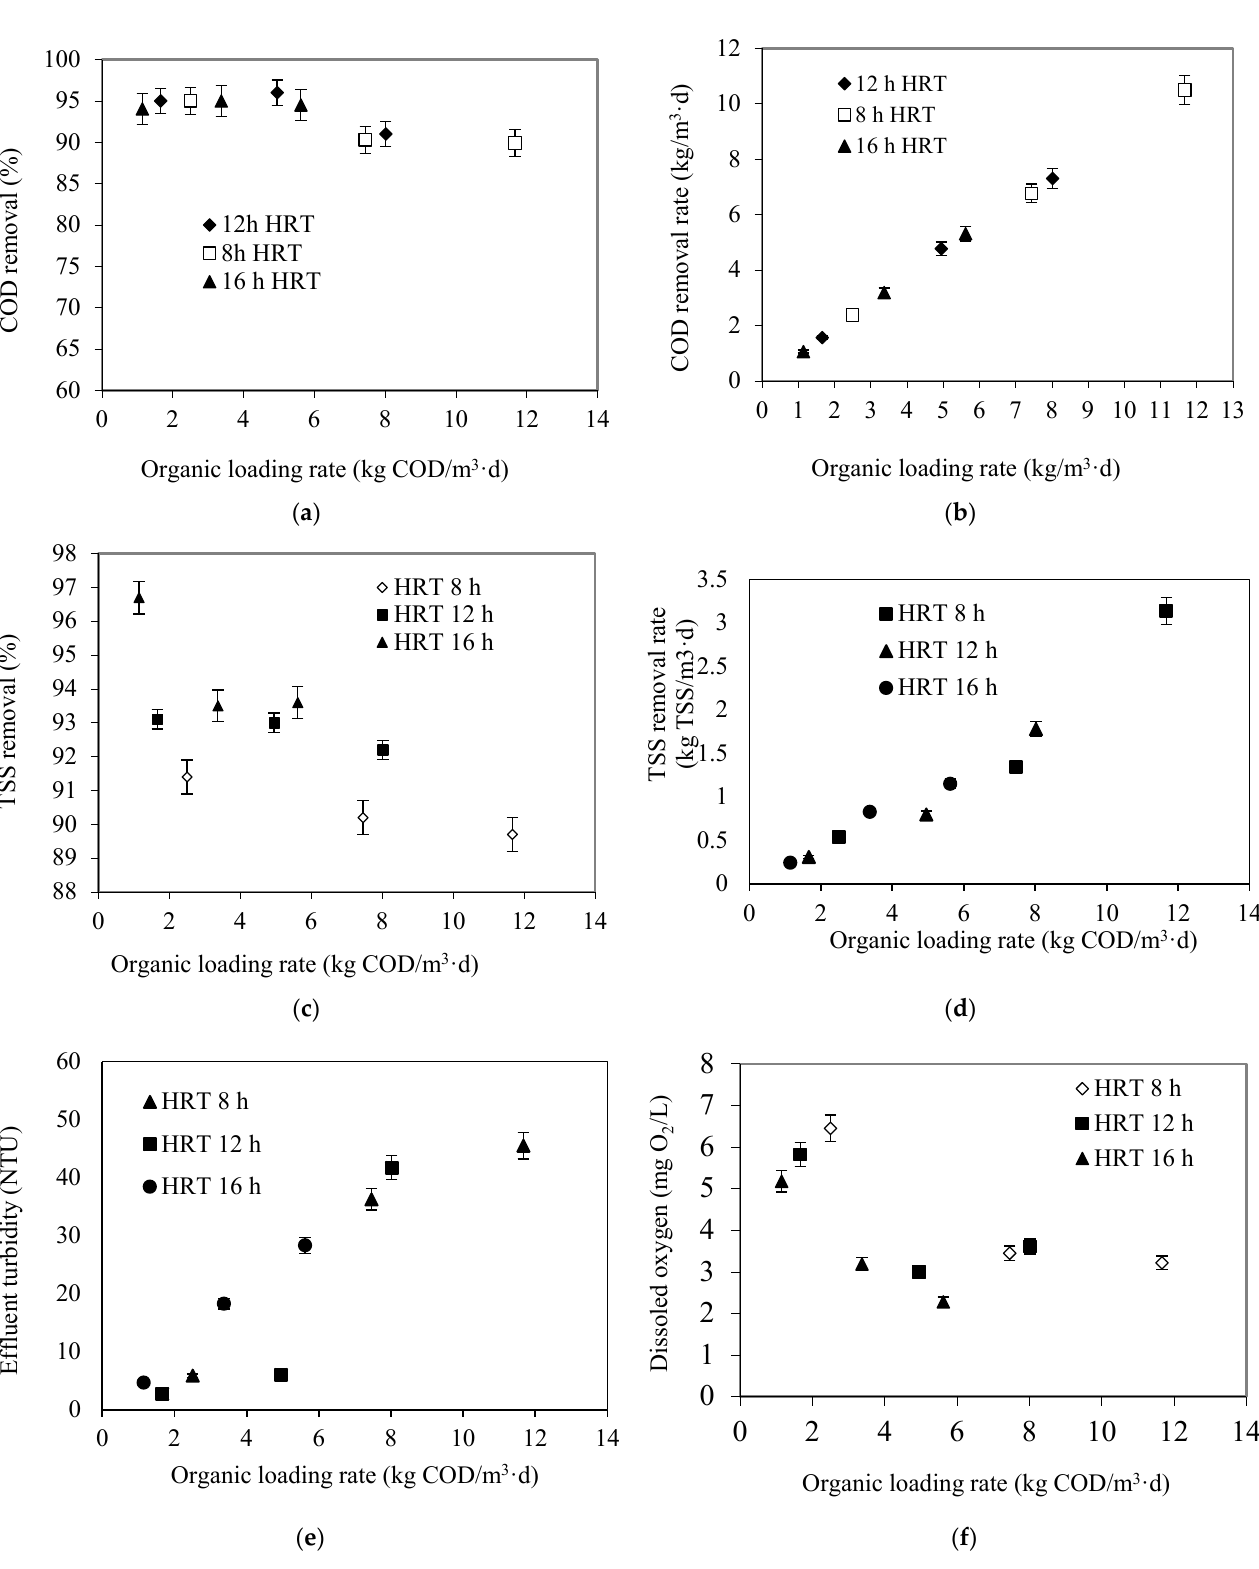
Figure 5. Effect of organic loading rate on ( a ) COD removal efficiency, ( b ) COD removal rate, ( c ) TSS removal efficiency, ( d ) TSS removal rate, ( e ) effluent turbidity, ( f ) DO concentration at different HRTs. ·